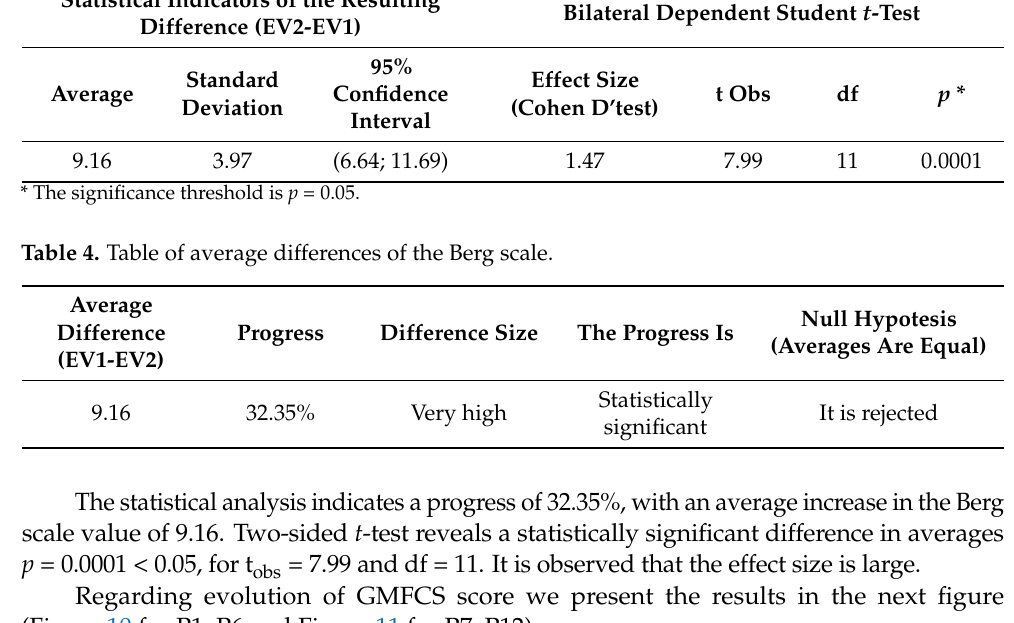
Table 3. The table of statistical indicators of the difference of the Berg scale. Statistical Indicators of the Resulting